Question: From the figure, is the trend upward or downward?
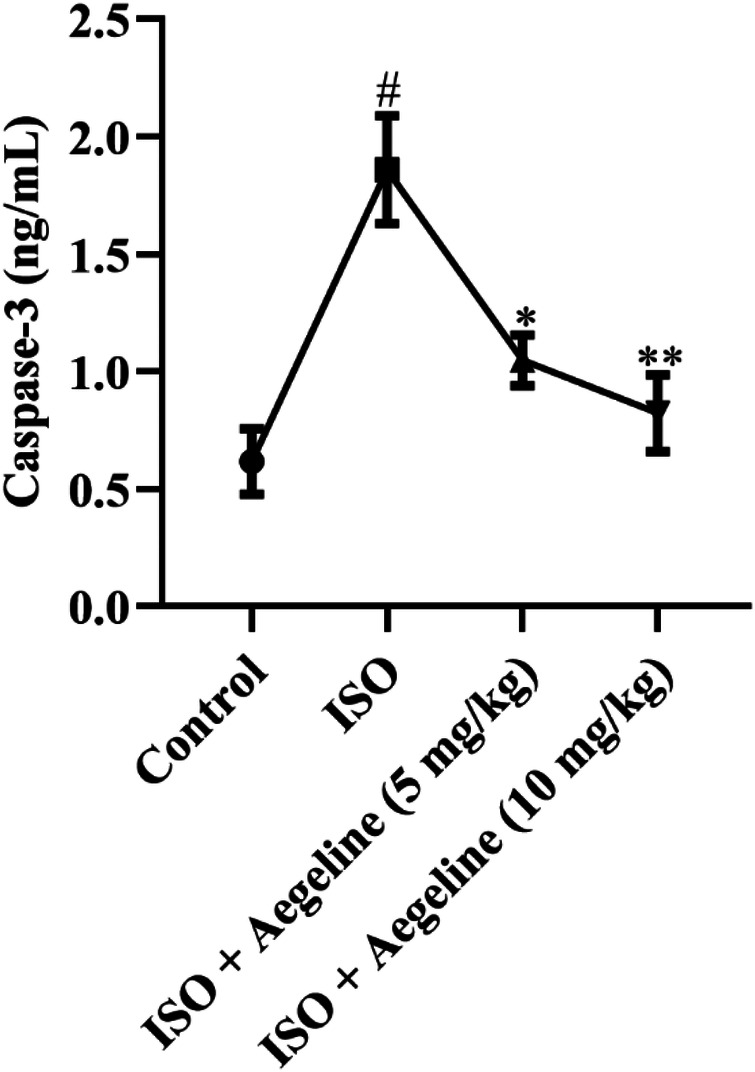
Answer: increasing